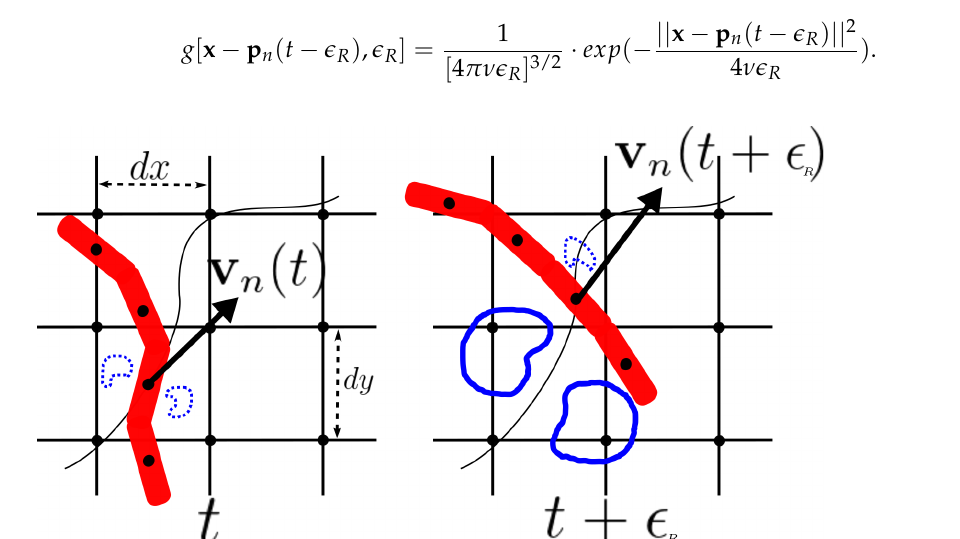
Figure 5. Schematic representation (freely inspired by [26]) of the two-way coupling according to the ERPP method. Left panel: the disturbance generated by the n th element moving with velocity v n ( t ) at the time-step t has yet to diffuse to the computational grid, whose spacing is indicated by dx and dy . Right panel: At time t + (cid:101) R , the n th element has moved along its trajectory while the previously generated disturbance has diffused enough to reach the computational grid with delay (cid:101) R